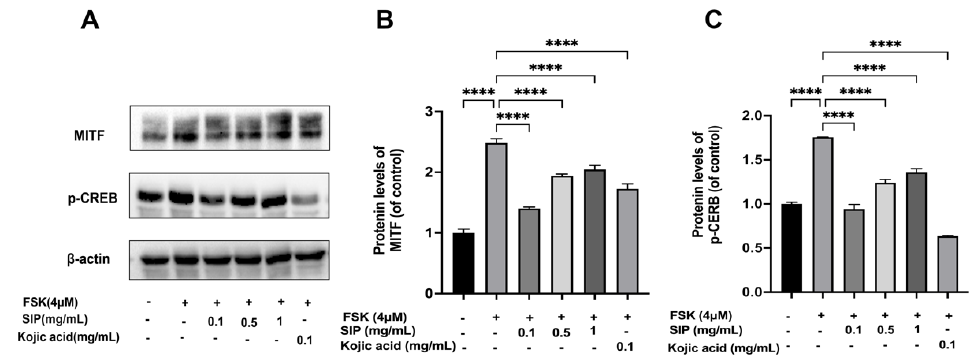
Figure 6. Effects of SIP on MITF and phosphorylated CREB ( p -CREB) protein expression levels in FSK-stimulated B16F10 melanoma cells. ( A ) MITF and p -CREB protein expression levels were detected by Western blot following SIP treatment with the indicated concentration. The densitometric analysis of MITF ( B ), and p -CREB ( C ) using the Photoshop software. Results were presented as mean